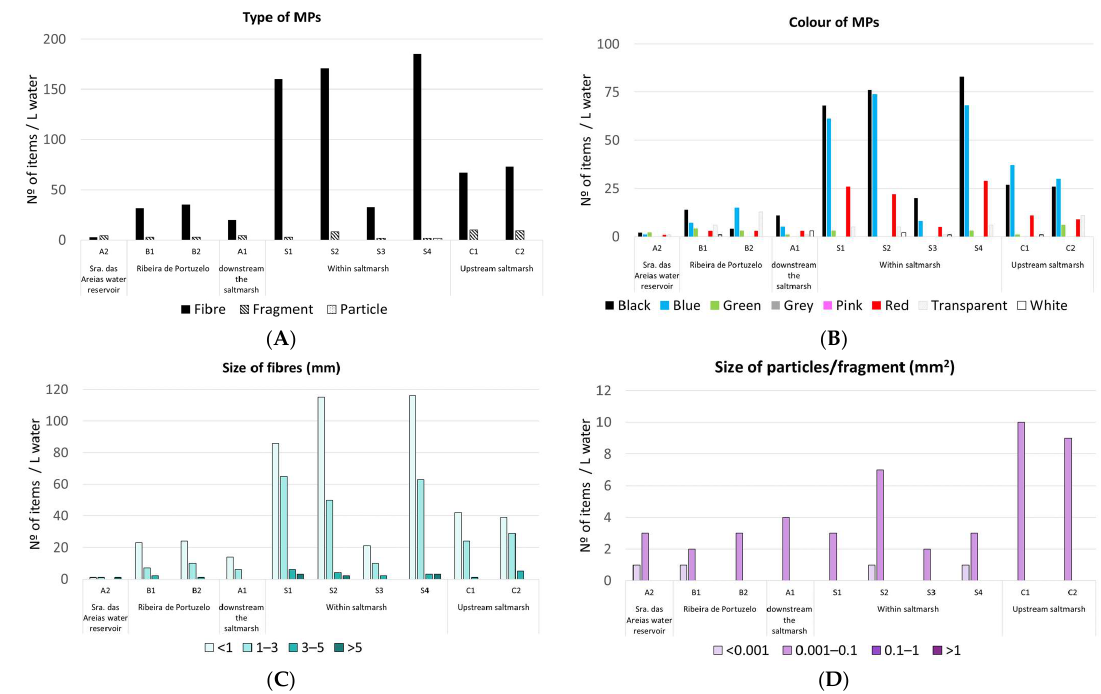
Figure 5. MPs content (number of items per L of water) and characterization from water samples collected in winter (February 2022), discriminated by: ( A ) Type of MPs; ( B ) Colour of MPs; ( C ) Size of fibres (mm); ( D ) Size of particles and fragments (mm 2